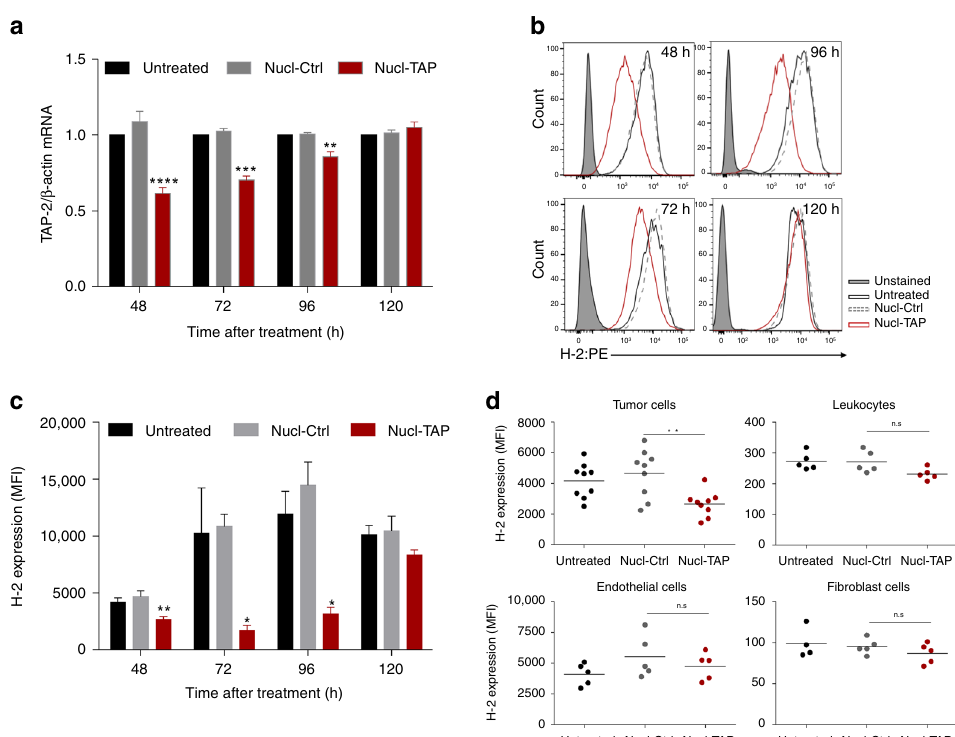
Fig. 2 Ef fi ciency and speci fi city of nucleolin aptamer-targeted delivery of TAP siRNA to tumor cells in vivo. Mice bearing subcutaneously implanted A20- GFP tumors were injected once intraperitoneally with Nucl-siRNAs, tumors were excised at the indicated times and analyzed for TAP mRNA and MHC class Ia expression. a GFP-expressing cells were isolated by cell sorting and TAP mRNA quanti fi ed by qRT-PCR (3 mice/group) ( n = 2). Data represent means and SEM. b – d MHC class Ia expression in A20-GFP tumors treated with Nucl-siRNA conjugates. b MHC class Ia expression in GFP + tumor cells isolated at the indicated times following Nucl-siRNA treatment, representative tumor. c Distribution within a group of 3 – 9 mice represented as mean + SEM. a and c Statistical analyses using one-way ANOVA test and Dunnet posttest for comparison between untreated and treated cells. d MHC class Ia expression 48 h following Nucl-siRNA treatment in GFP + tumor cells and GFP − tumor resident leukocytes, endothelial cells and fi broblasts (4 – 9 mice/ group). Each circle represents an individual mouse, and means per group are shown ( n = 2). Statistical analyses using Kruskal – Wallis test and